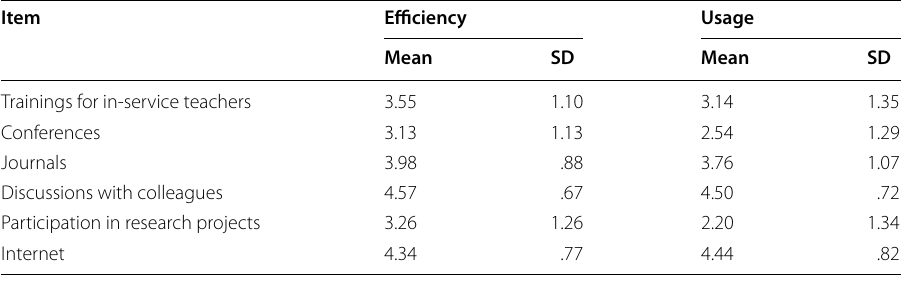
Table 4 Efficiency and usage of different information sources in teachers’ professional developed as judged by the teachers Item